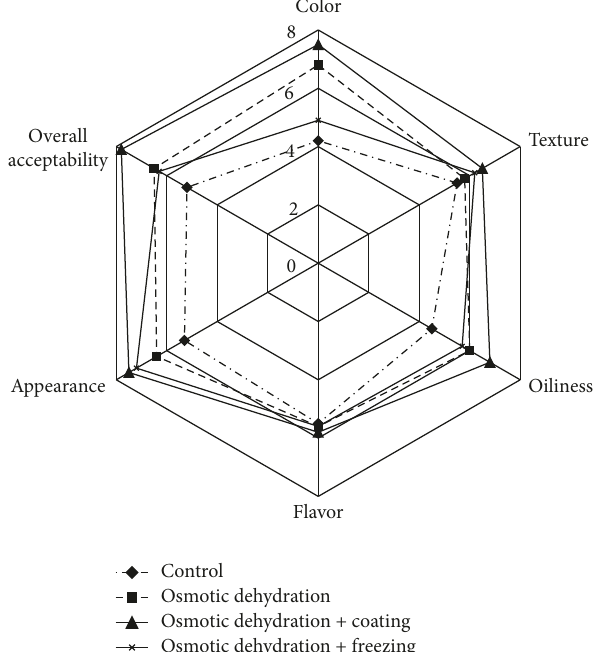
Figure 4: Sensory evaluation of the quality of vacuum-fried shiitake mushroom chips in four experimental